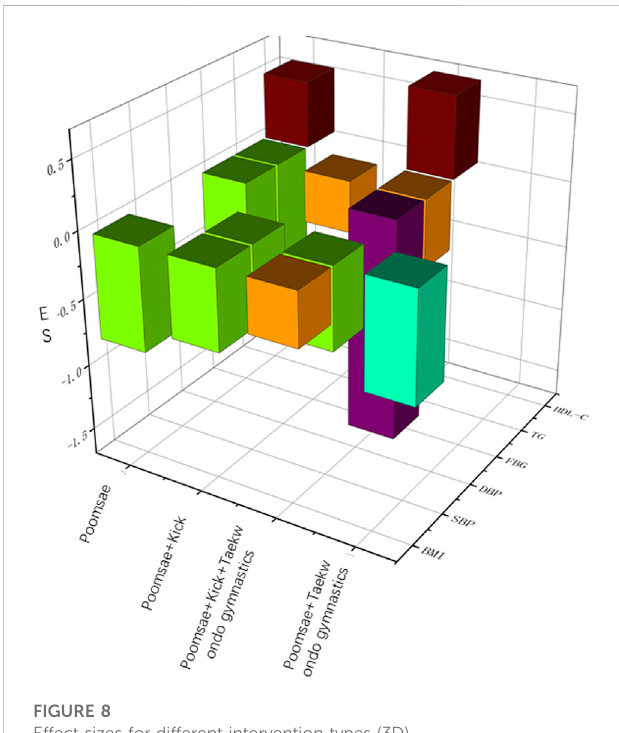
FIGURE 8 Effect sizes for different intervention types